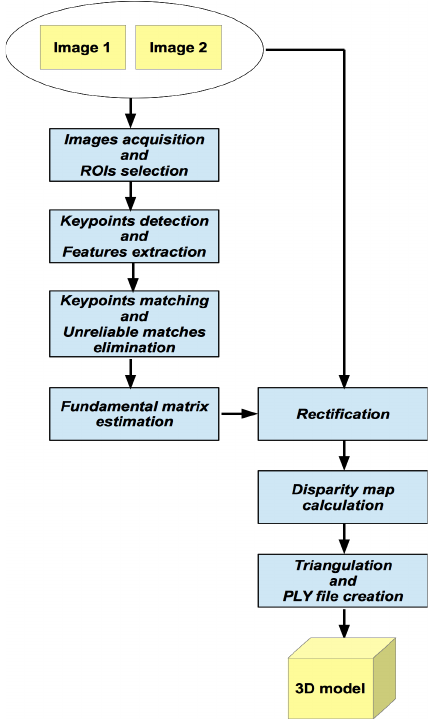
Figure 2. Block diagram of the proposed 3D reconstruction